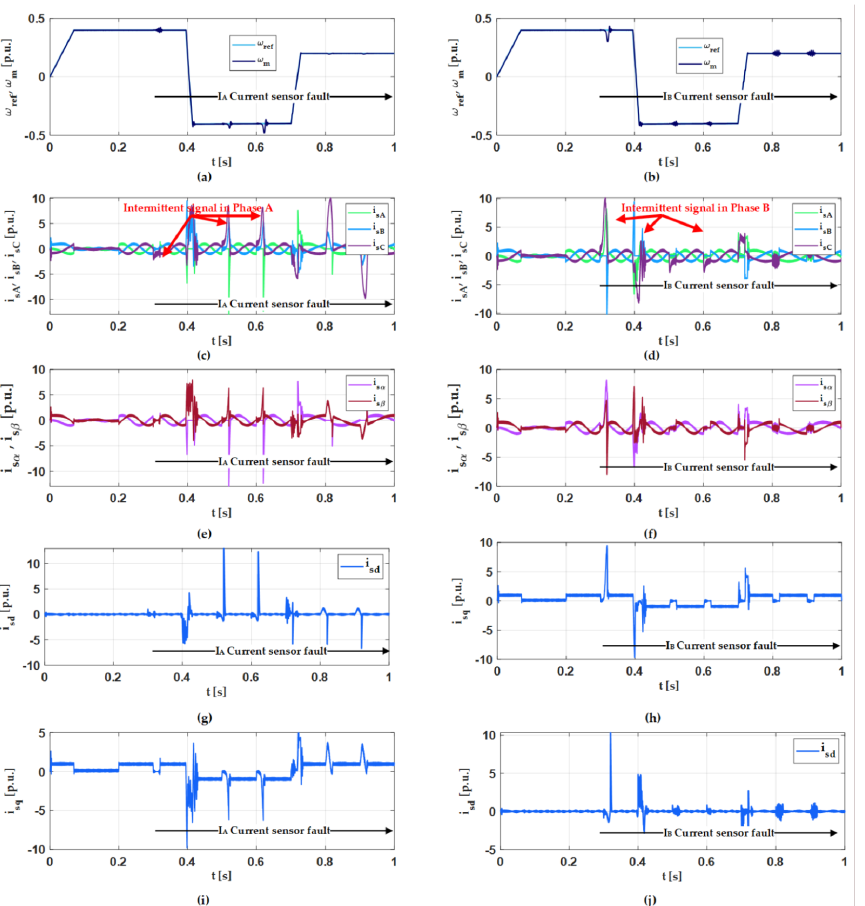
Figure 7. Influence of intermittent signal on speed transients in phase A ( a ) and B ( b ), phase currents, currents i sA , i sB , i sC in phase A ( c ) and B ( d ), stator current components i s α , i s β in phase A ( e ) and B ( f ) and currents i sd , i sq in phase A ( g , i ) and B ( h , j ) in the FOC